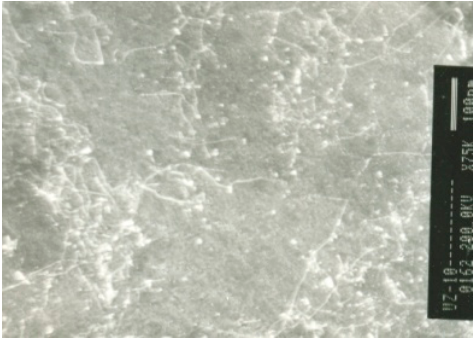
Figure 8. TEM micrograph of the interaction between precipitates and dislocations [20].